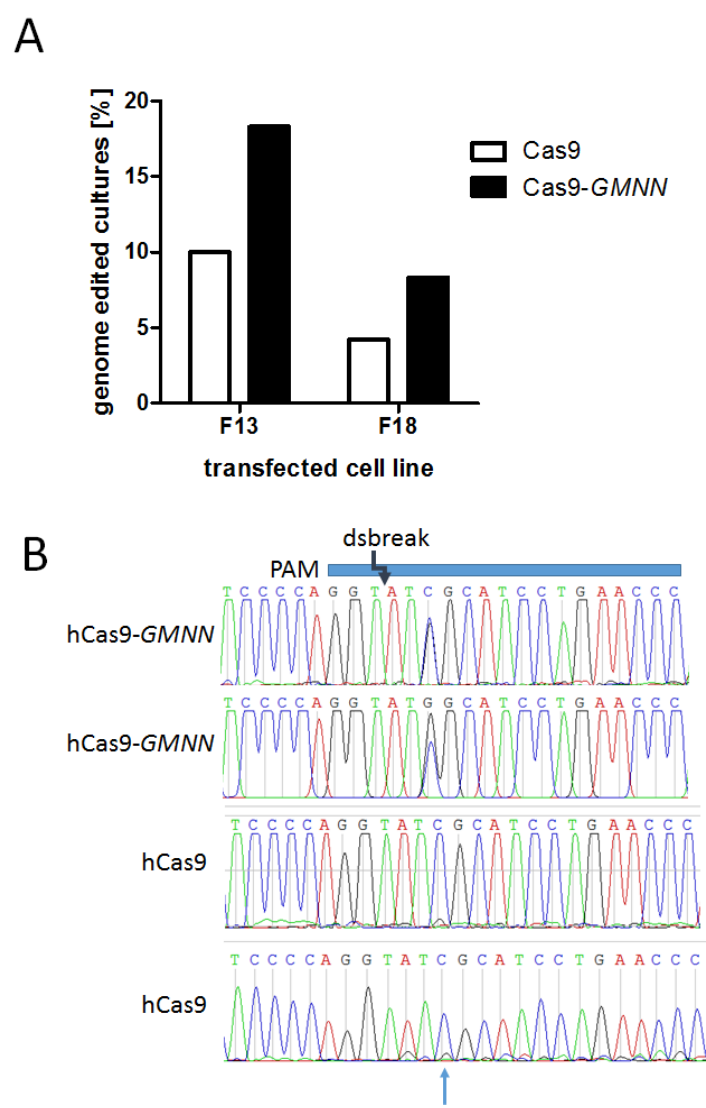
Figure 3. Efficacy of Cas9 and Cas9- GMNN -based knock-in in porcine fibroblasts. Porcine fetal fibroblasts were transfected in parallel experiments with ssODN encoding the point mutation R723G and CRISPR/Cas9 expression vectors either encoding for the Cas9 or the Cas9- GMNN fusion protein. The cells were plated at a density of 5 cells per well and cultivated until confluency in 96 well plates. ( A ) Cells were lysed and subjected to real time PCR screening for cultures with R723G-DNA. Two different fibroblast cell lines, F13 and F18, were transfected and screened for R723G-positive cultures. The percentage of R723G-positve cultures for the Cas9 and the Cas9- GMNN is plotted; ( B ) the genome edited locus of R723G-positive cultures was PCR-amplified and subjected to Sanger sequencing. Exemplary sequence chromatograms of two cultures each edited by hCas9- GMNN (upper panels) or hCas9 (lower panels), respectively, are shown. The protospacer adjacent motif (PAM) sequence, the protospacer (blue horizontal bar), and the position of the Cas9-induced double strand break are indicated schematically, the position of the point mutation is indicated by an arrow. Only hCas9- GMNN edited cultures showed high knock-in ratios of the point mutation C > G. Importantly, no additional alteration was detected at the double strand break locus. In contrast, hCas9 cultures show a substantially lower peak for the substituted G and additional modifications were detected.